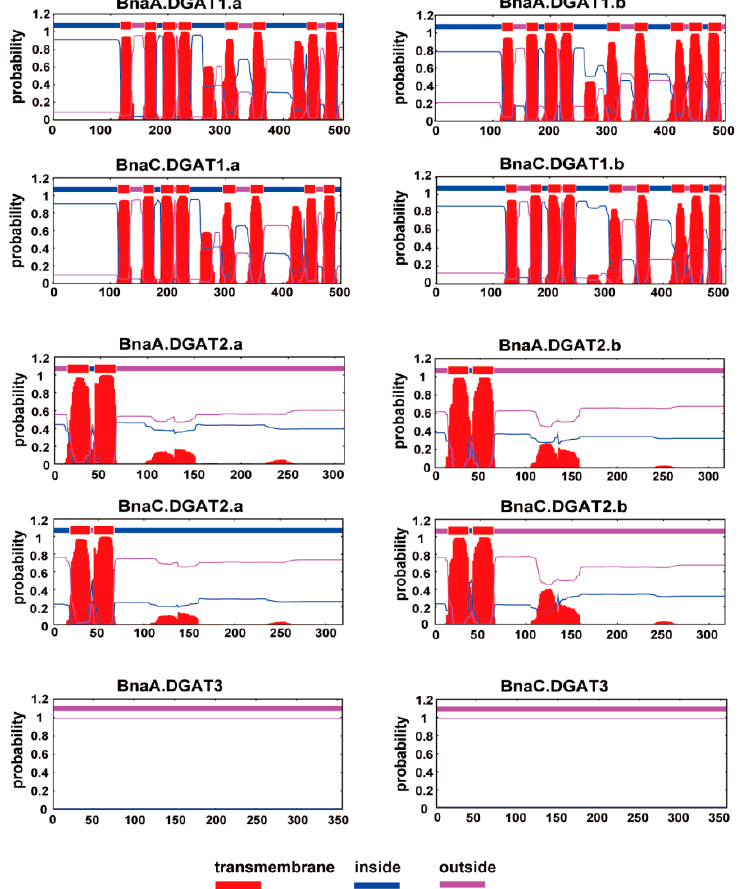
Figure 3. Predicted transmembrane domains (TMDs) of BnaDGATs. Each BnaDGAT1s had eight or nine putative TMDs, and each BnaDGAT2s showed two putative TMDs. However, neither BnaDGAT3 had putative TMDs. The putative TMDs of BnaDGATs were predicted using TMHMM Server v. 2.0 (https://services.healthtech.dtu.dk/service.php?TMHMM-2.0 (accessed on 10 April 2021)). Regions of BnaDGATs predicted to be located inside or outside the membrane are shown in bold blue and pink lines, respectively.